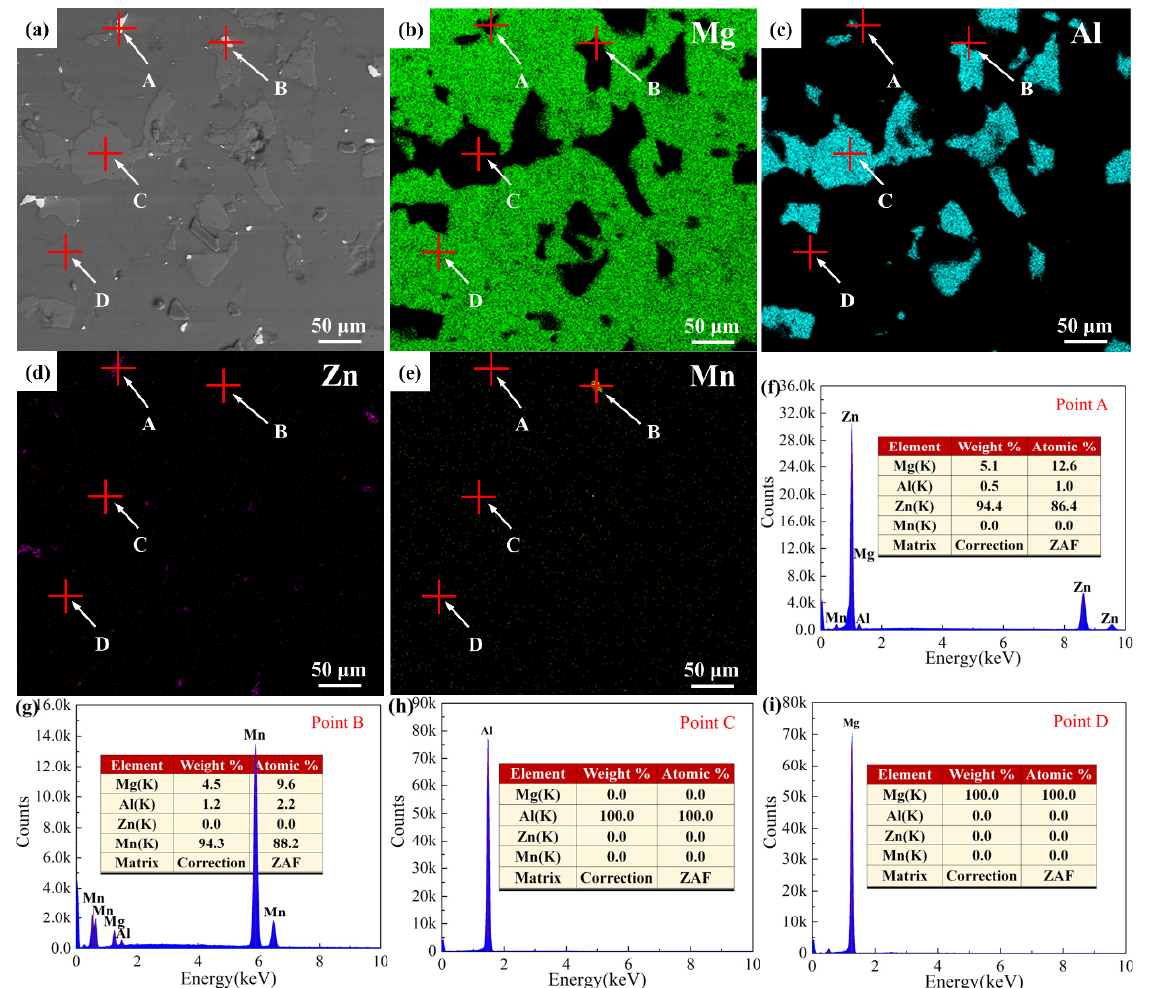
Figure 4. Microstructure of Mg-9Al-Zn-0.3Mn: ( a ) BSE image; ( b – e ) element distribution results; ( f – i ) EDS results of points A–D in ( a ).